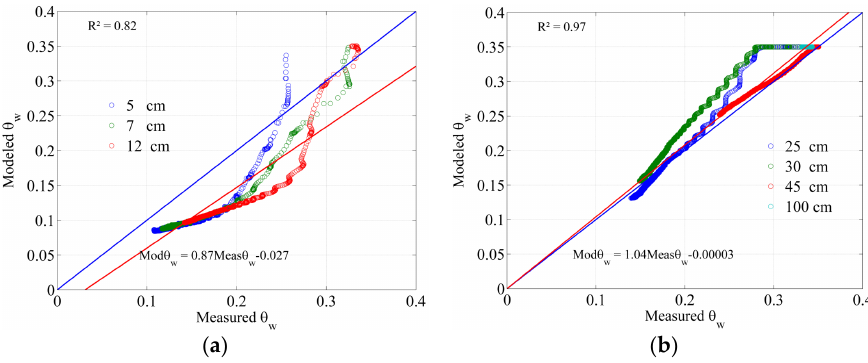
Figure 12. Soil water content θ w measured by sensors versus soil water content obtained by hydrodynamic modeling at shallow ( a ) and greater ( b ) depths. Blue line represents 1:1 line and red is the best linear fit.